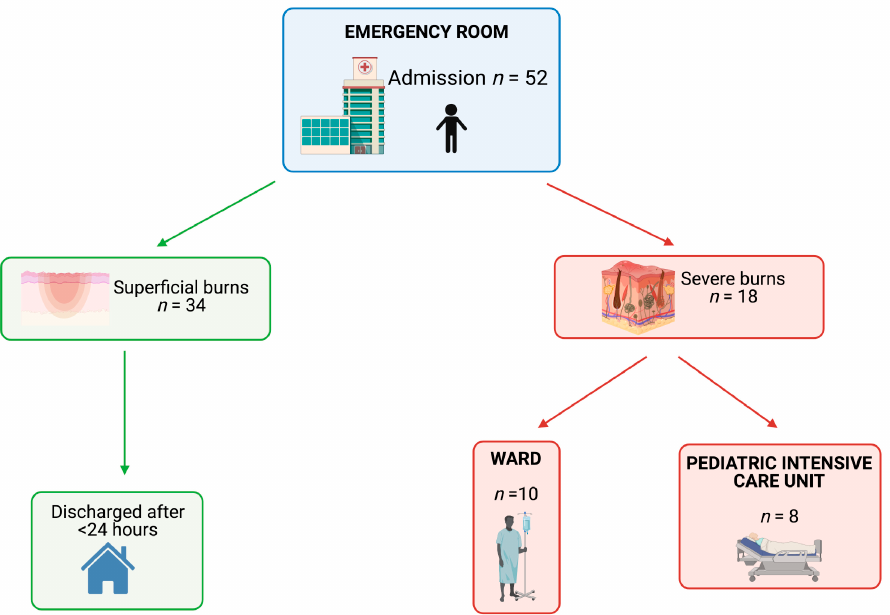
Figure 2. Flow chart of the children admitted to the emergency room. Created with BioRender.com (https://biorender.com/) (access on 7 May 2021). Table 2. Features of the patients admitted to the COVID-19 Service.